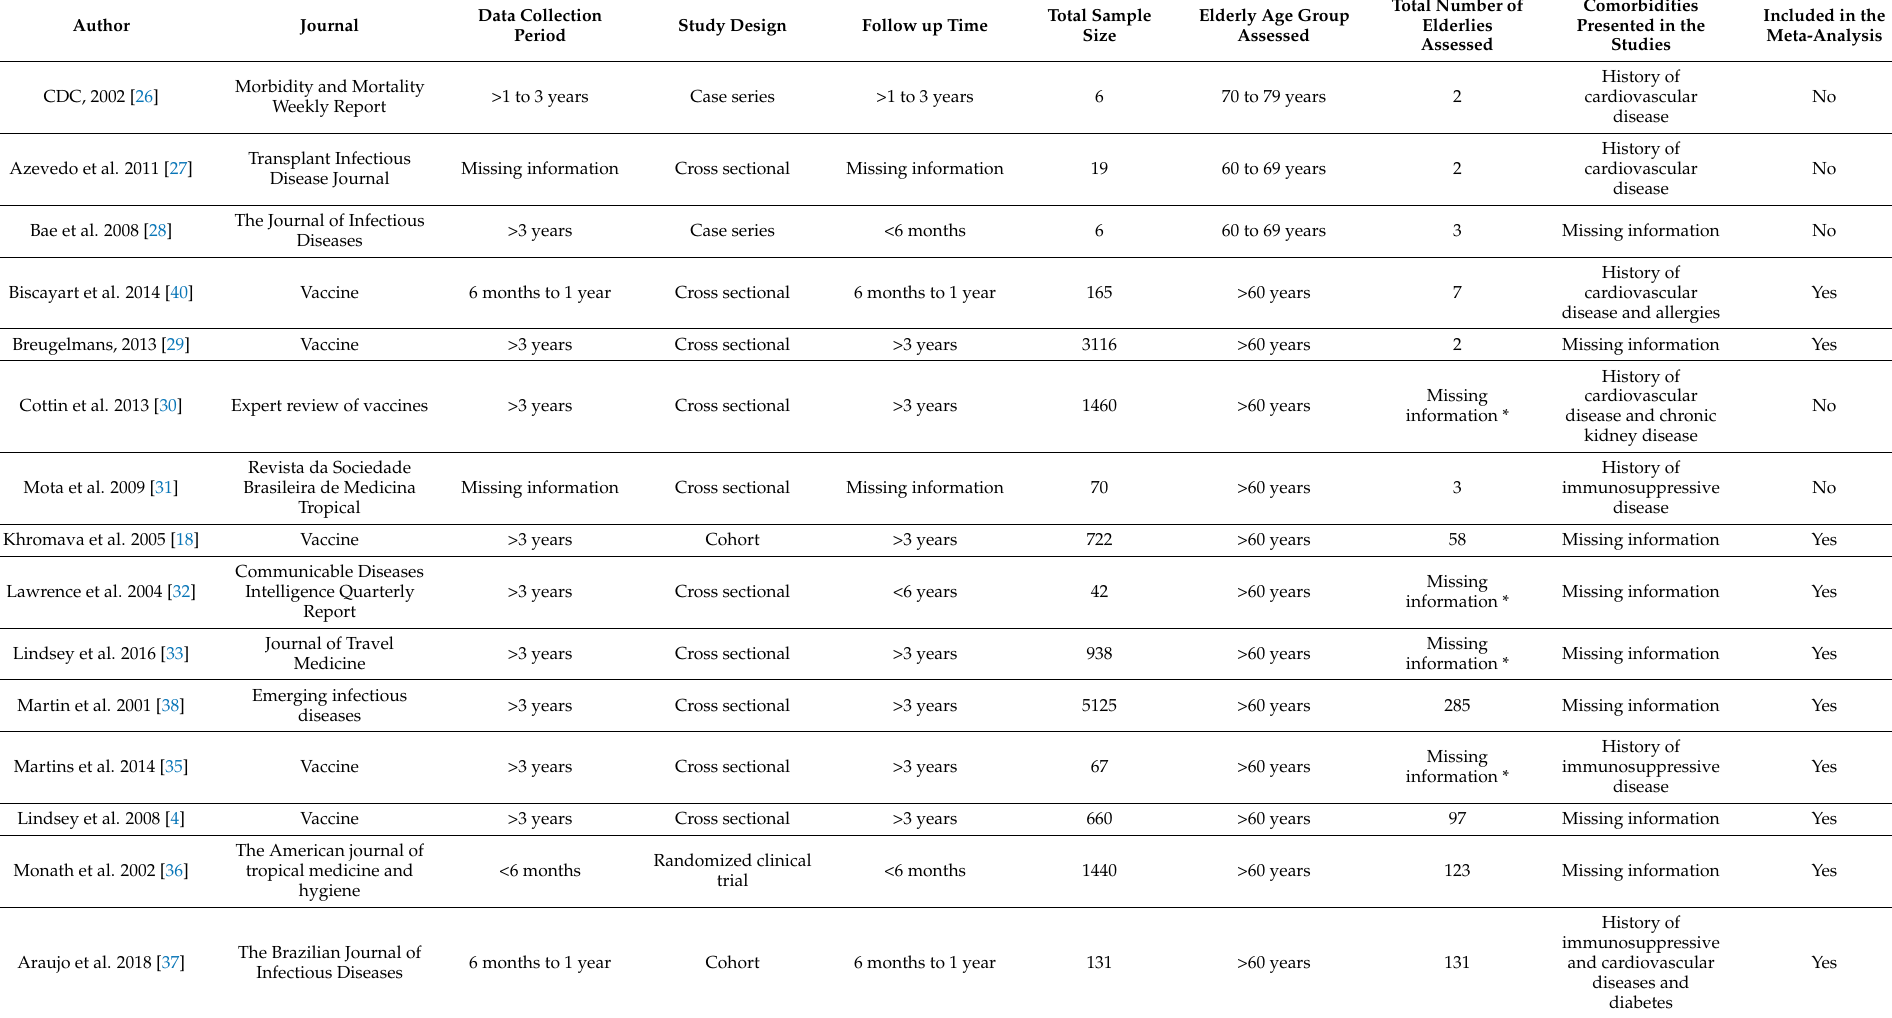
Table 1. Characteristics of the studies included in the